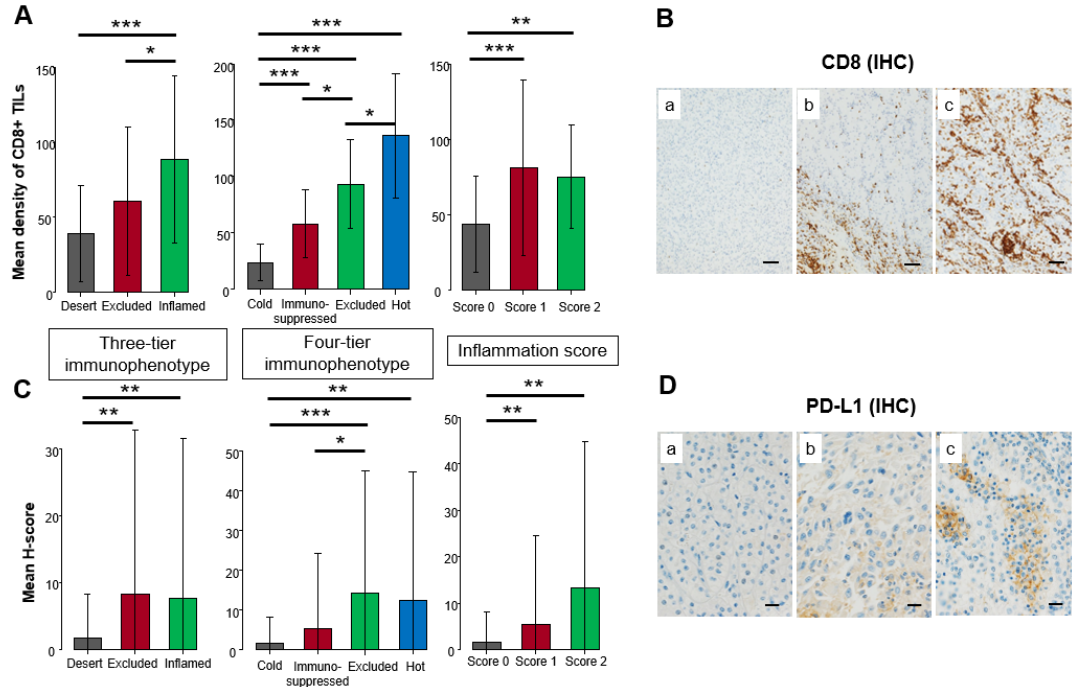
Figure 3. Comparison of immunohistochemical expression among three-tier and four-tier im- munophenotype and inflammation score in the principal cohort. ( A ) Mean density of CD8+ tumor- infiltrating lymphocytes (TILs). ( B ) Representative example of CD8 immunohistochemistry (IHC). The brown color showed positive staining of immunohistochemistry whereas the blue color showed a counterstain of cell nuclei. ( a ). none, ( b ). CD8+ TILs accumulated in the peritumoral area, ( c ). CD8+ TILs infiltrated in the intratumoral area. Scale bar: 200 µ m. ( C ) Mean H-score of PD-L1 expression on cancer cells. ( D ) Representative example of PD-L1 IHC. The brown color showed positive staining of immunohistochemistry whereas the blue color showed a counterstain of cell nuclei. ( a ). none, ( b ). focal weak positivity, ( c ). focal strong positivity. Scale bar: 20 µ m. One-way analysis was used for statistical analysis (* p < 0.05, ** p < 0.01, *** p < 0.001 assessed by Mann–Whitney